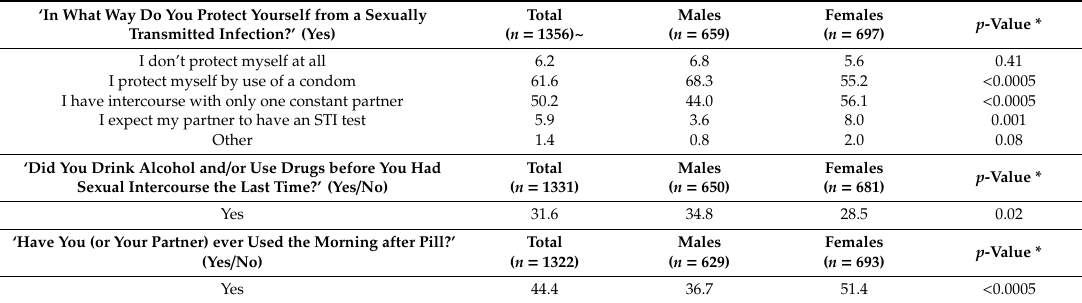
Table 4. Sexual health behaviours: males versus